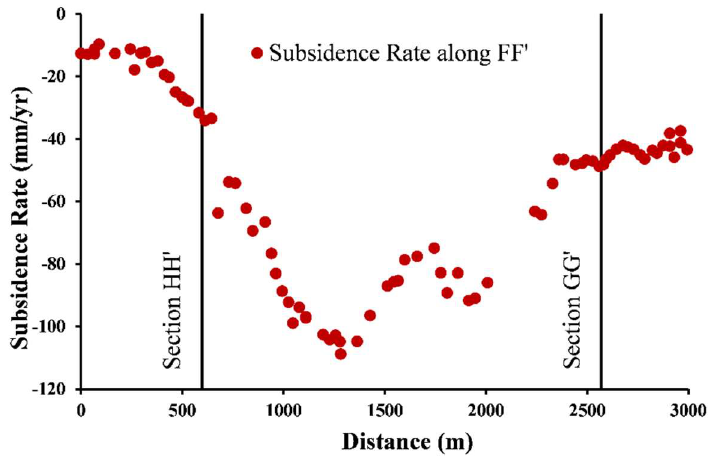
Figure 10. Profile of faults (section HH’ and GG’) and subsidence rate of section FF’ in Figure